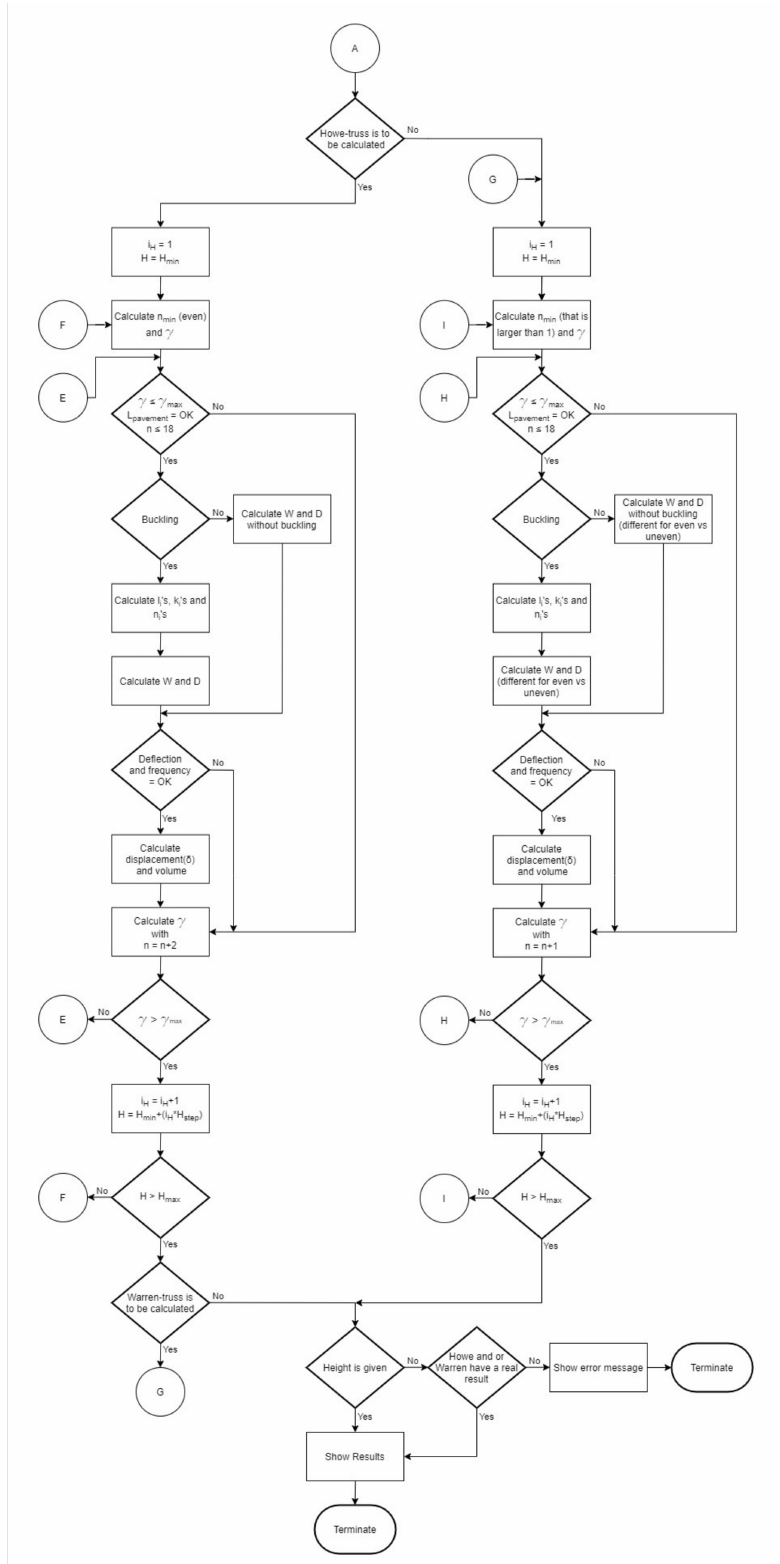
Figure 6. Flowchart software, part